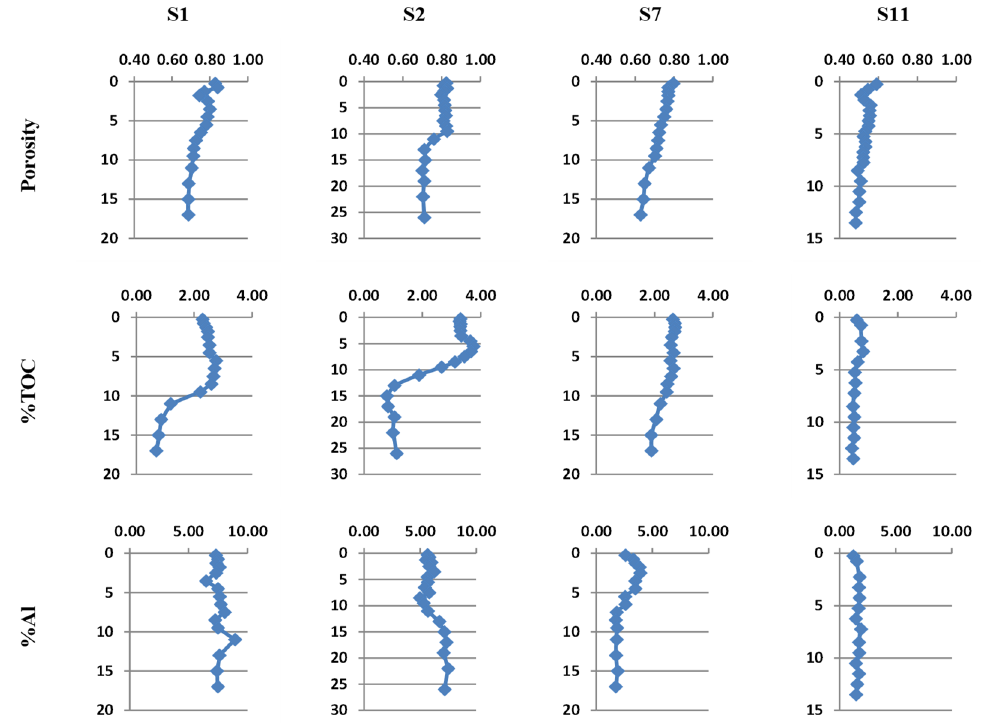
Figure 2. Porosity, Total Organic Carbon (TOC, %), and Al (%) concentrations in sediment cores from Stations S1, S2, S7, and S11. Vertical axis represents depth (cm).